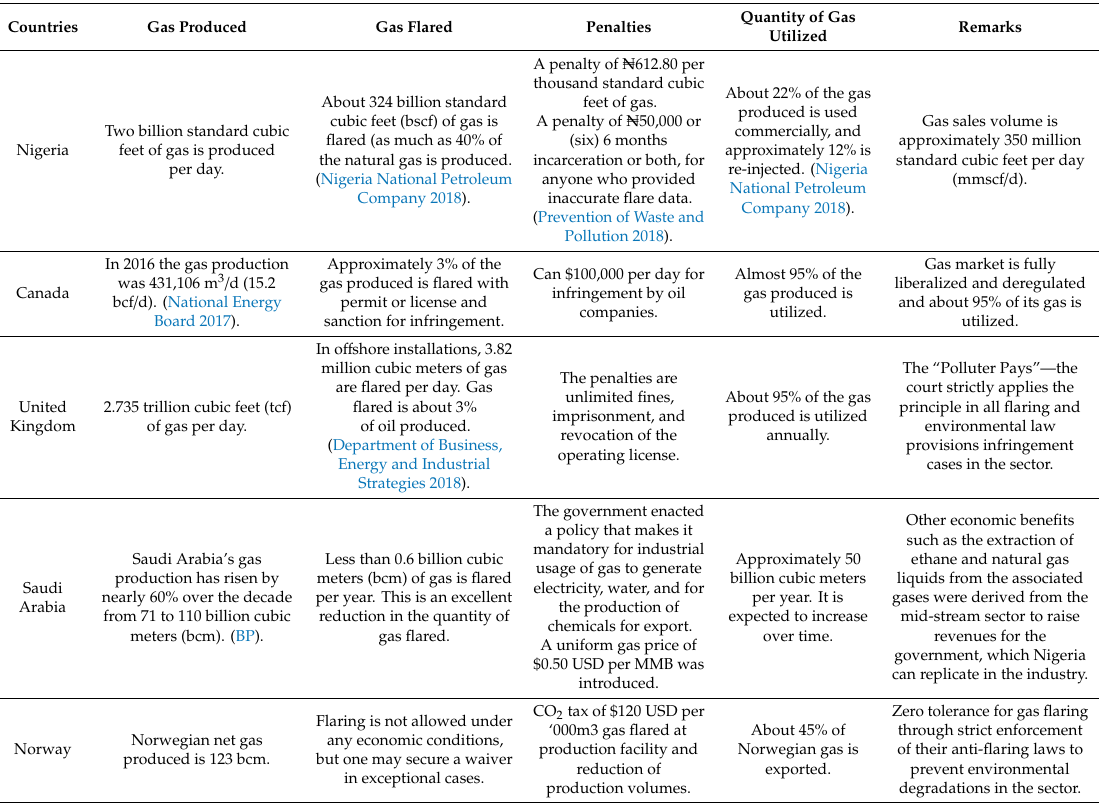
Table 2. Comparison of Gas Flared in Nigeria, Canada, the United Kingdom, Saudi Arabia, and Norway with the Approved